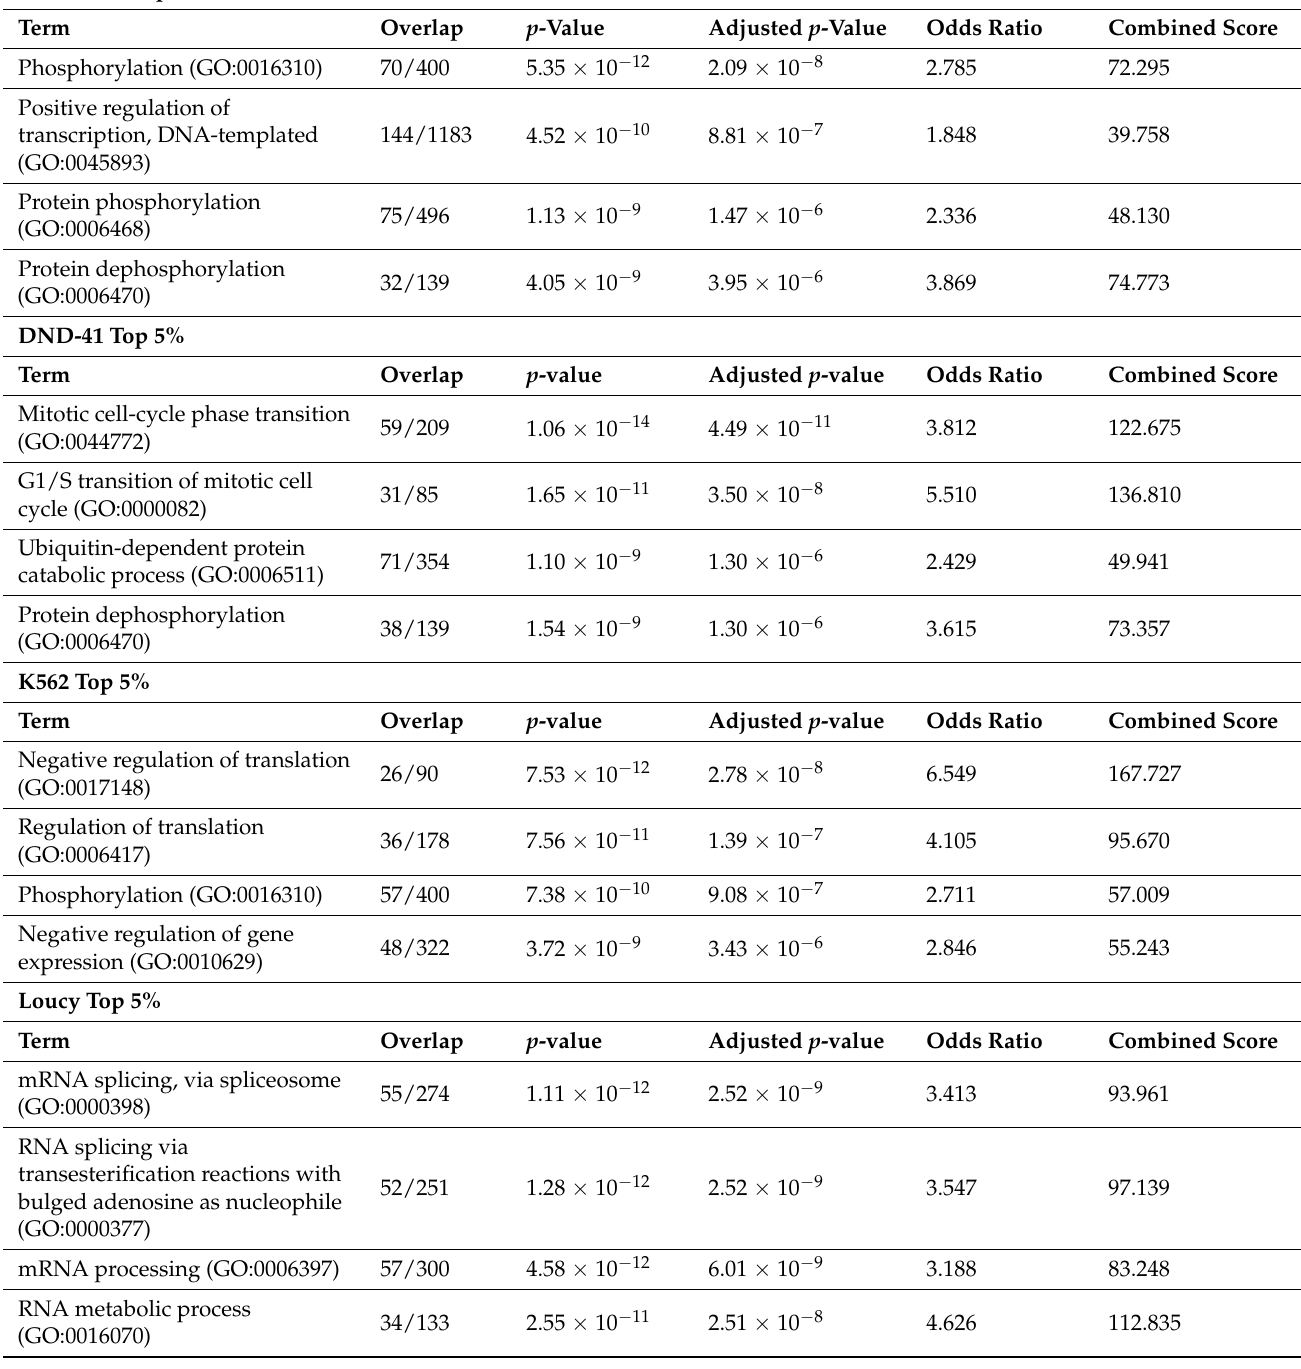
Table 1. GO terms (biological processes) for genes with the broadest H3K79me2 domains in leukemic